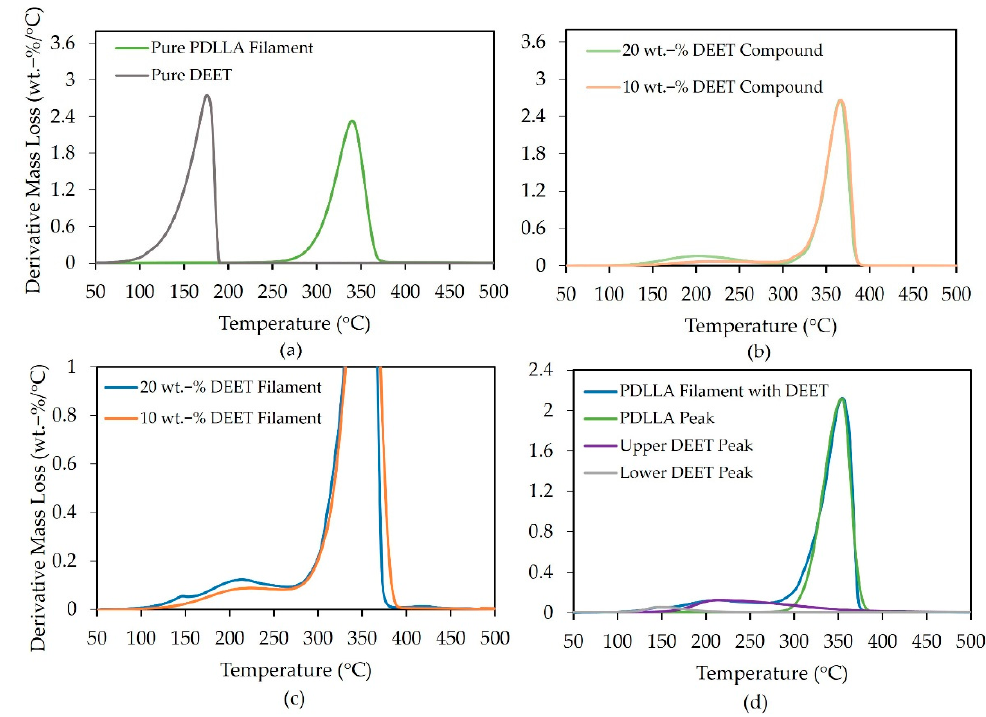
Figure 8. TGA derivative-mass-loss curves of DEET and PDLLA monofilaments ( a ) without DEET, ( b ) PDLLA-DEET compounds with varying DEET content, ( c ) PDLLA monofilaments with varying DEET content and ( d ) a representative deconvolution curve of 20 wt.-% DEET monofilaments.